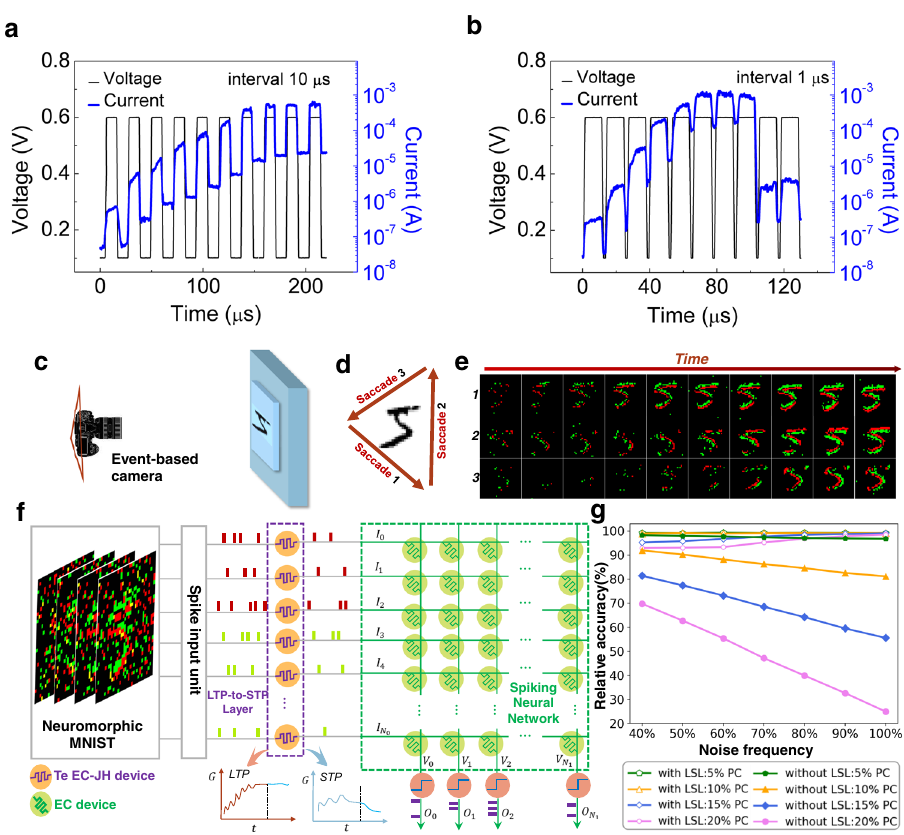
Fig. 5 LTP-to-STP transition under pulse train stimuli and the proposed spike event preprocessing application. ( a ) Pulse train measurement with write pulse width of 10 μ s, amplitude of ±0.6 V and 10- μ s interval. ( b ) Pulse train measurement with the same pulse width and amplitude, but 1- μ s interval. ( c ) Schematic diagram of neuromorphic data acquisition via event-based camera. ( d ) Three saccade trajectories of the camera during data acquisition process. ( e ) Event-based data acquired by the camera along the three saccade trajectories. ( f ) Schematic diagram of SNN processing of the N-MNIST data with LSL. ( g ) Performance comparison between SNNs with LSL and without